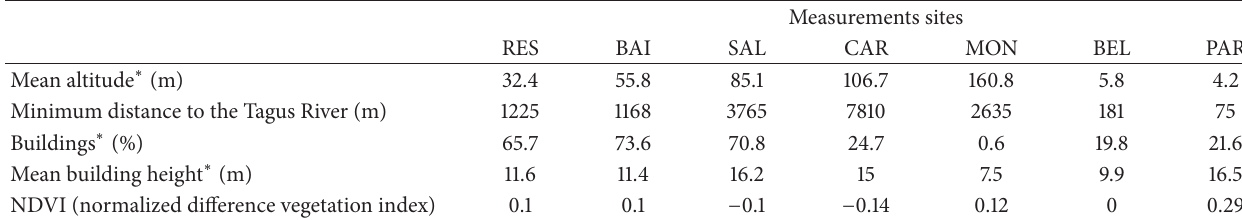
Figure 1: Location of the measurement sites of the Lisbon mesoscale network. On the right, the radiation shield, containing the thermohy- grometer, in “Restauradores,” is shown. Table 1: Characterization of the measurement sites of the Lisbon mesoscale network (RES: Restauradores, BAI: Bairro Alto, SAL: Saldanha, CAR: Carnide, MON: Monsanto, BEL: Bel´em, and PAR: Parque das